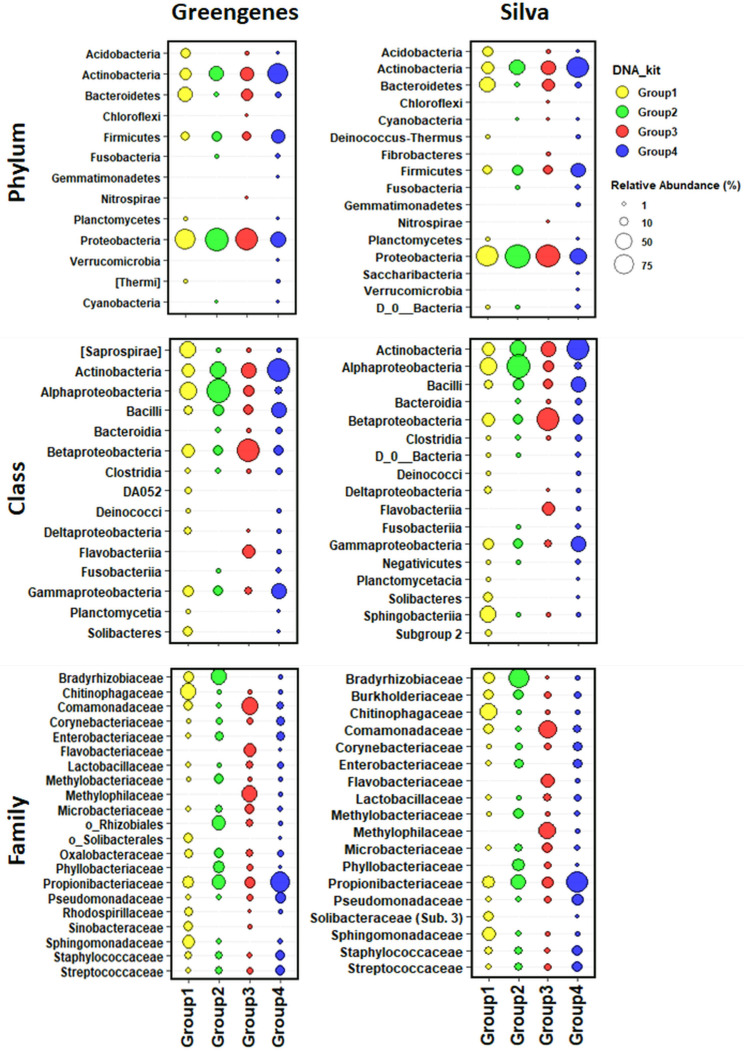
Taxonomic bubble plot of olive xylem bacteria relative abundance at phylum, class, and family level present in four groups of DNA extraction kits and after taxonomic assignments with the Greengenes_13-8 and Silva_132 databases. Circle sizes represent the relative abundance, and colors indicate DNA extraction kit groups shown in Figure 2. Only abundances greater than 1% are shown.